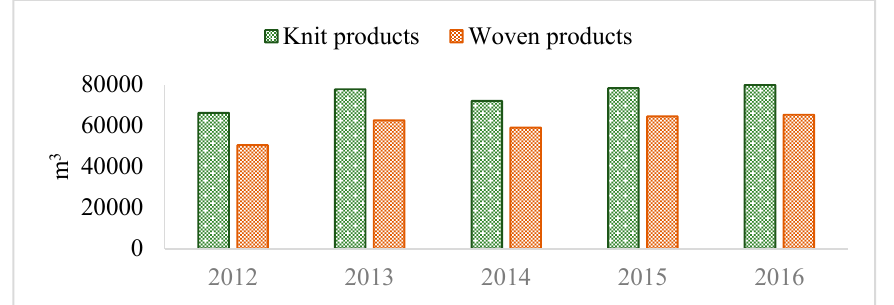
Figure 6. Blue water footprint for transportation.